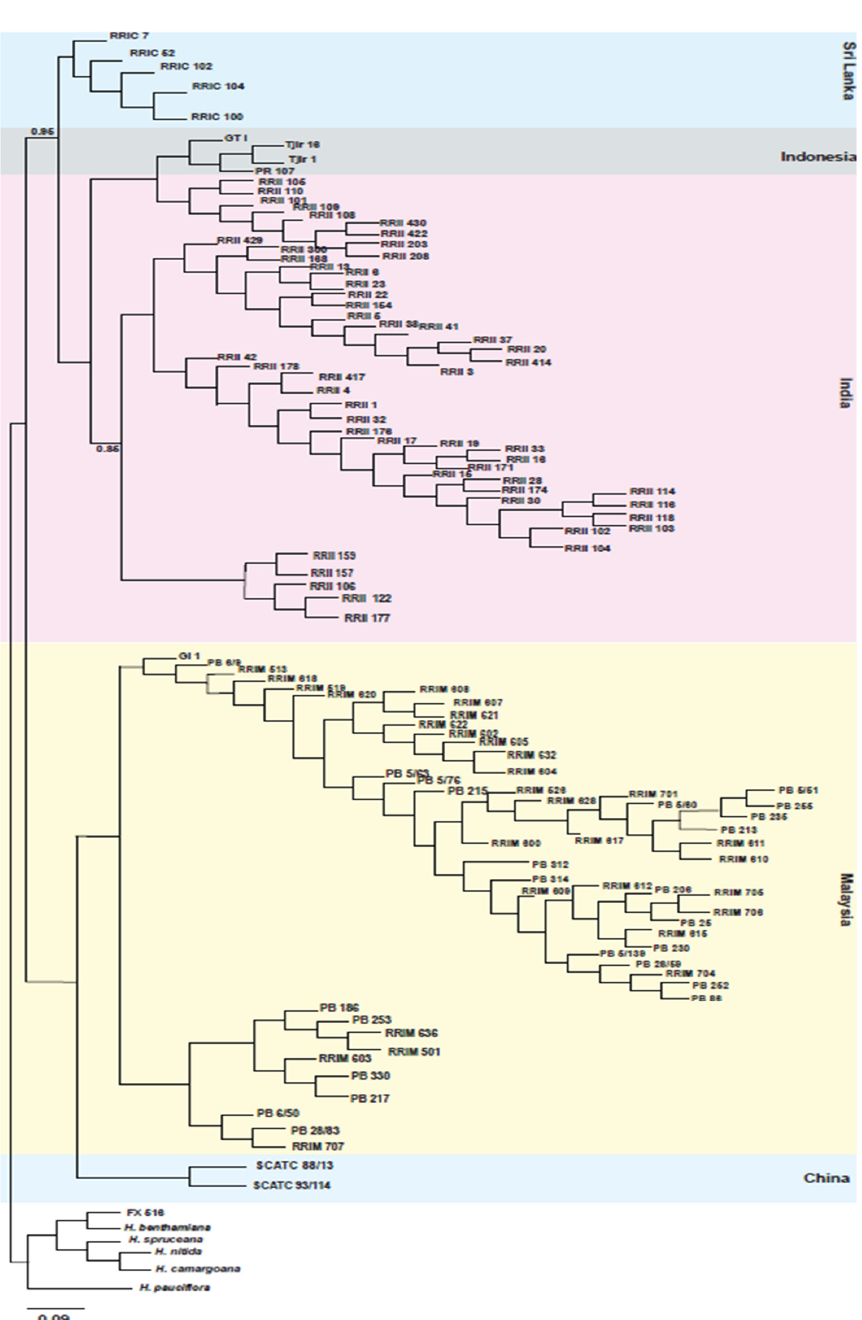
Figure 1. Phylogenetic tree constructed for 116 clones using SNP markers obtained from DArTSeq. Values indicated on the nodes are Bayesian posterior probabilities and are 1.0 unless otherwise indicated. The scale bar represents the probability of nucleotide substitutions per site.